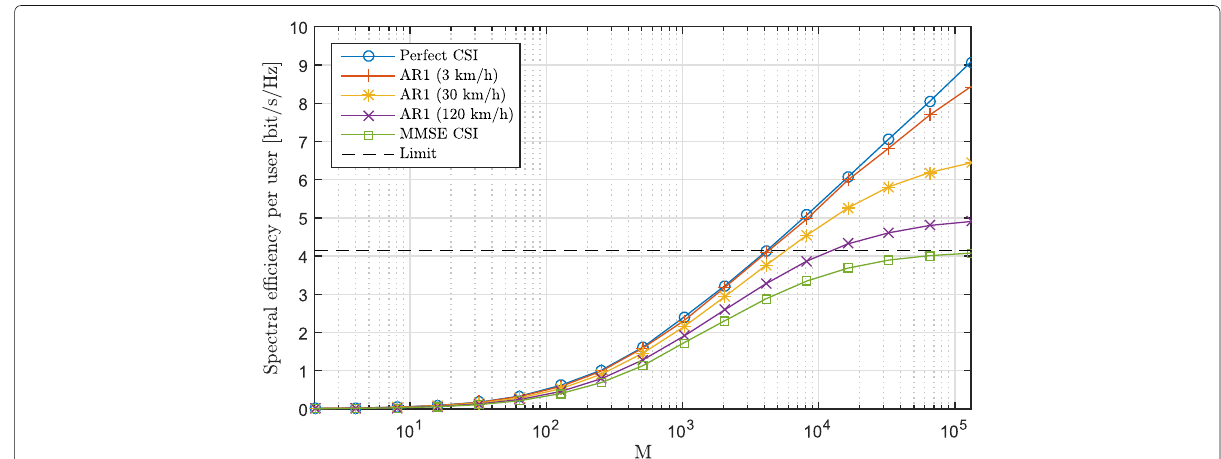
Fig. 15 The achievable downlink rate as a function of the number of antennas, M , at the BS